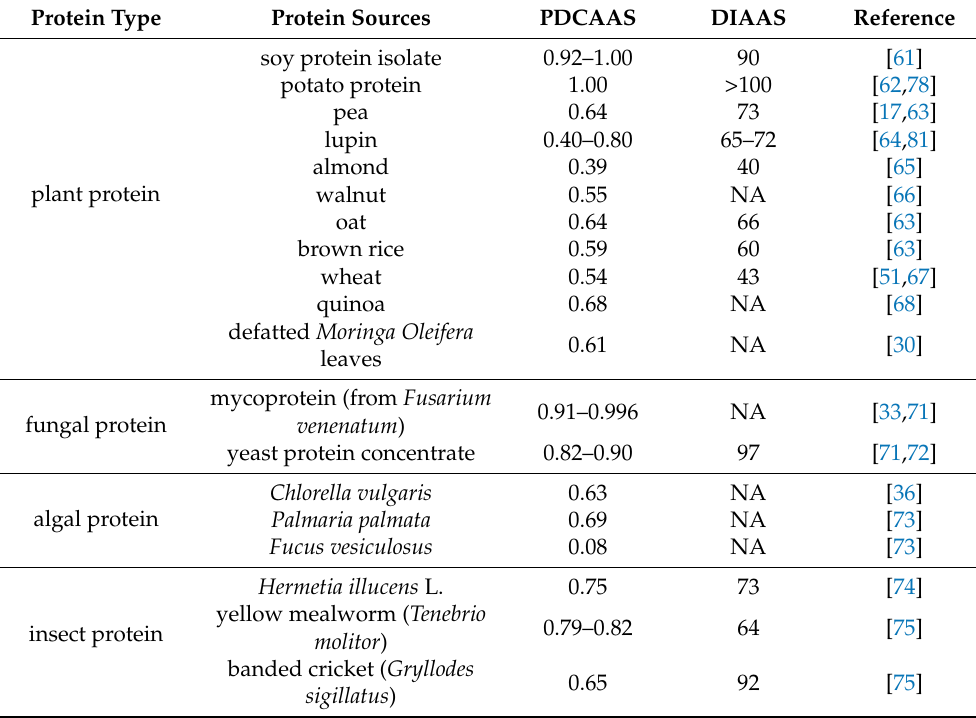
Table 2. PDCAAS and DIAAS of some reported alternative